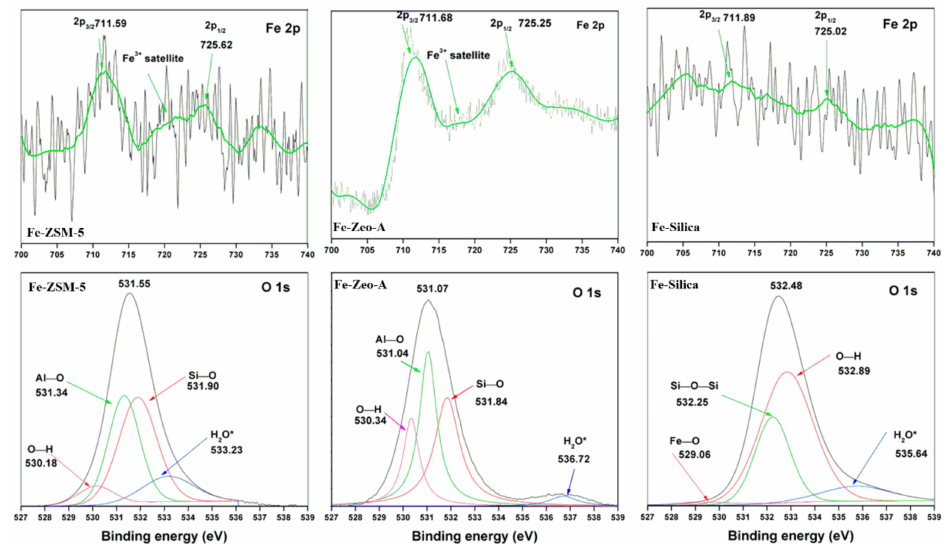
Figure 3. HRXPS Fe 2p and deconvoluted HRXPS O 1s spectra of Fe-ZSM-5, Fe-Zeo-A, and